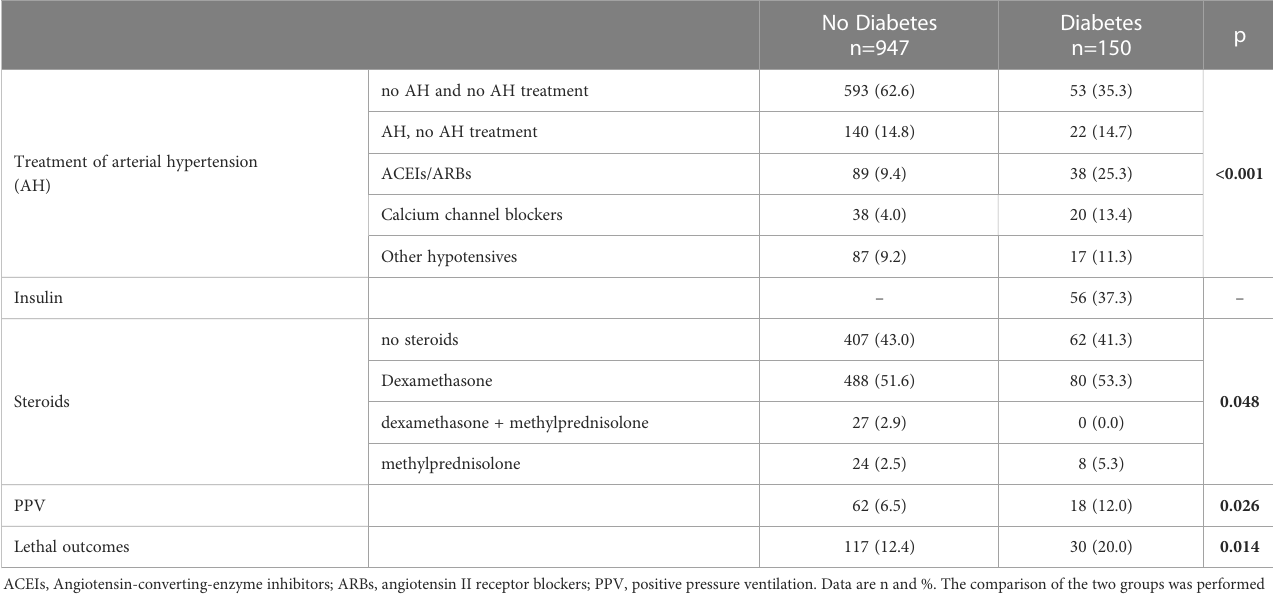
TABLE 2 Distribution of some treatments and mortality of patients with COVID-19 depending on their “ diabetes mellitus ” diagnosis at the time of admission to the infectious disease hospital.